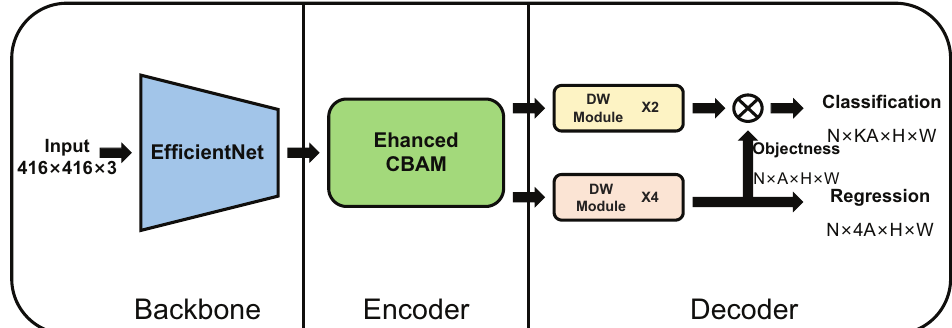
Figure 11. Overall architecture of the Enhanced Channel Attention